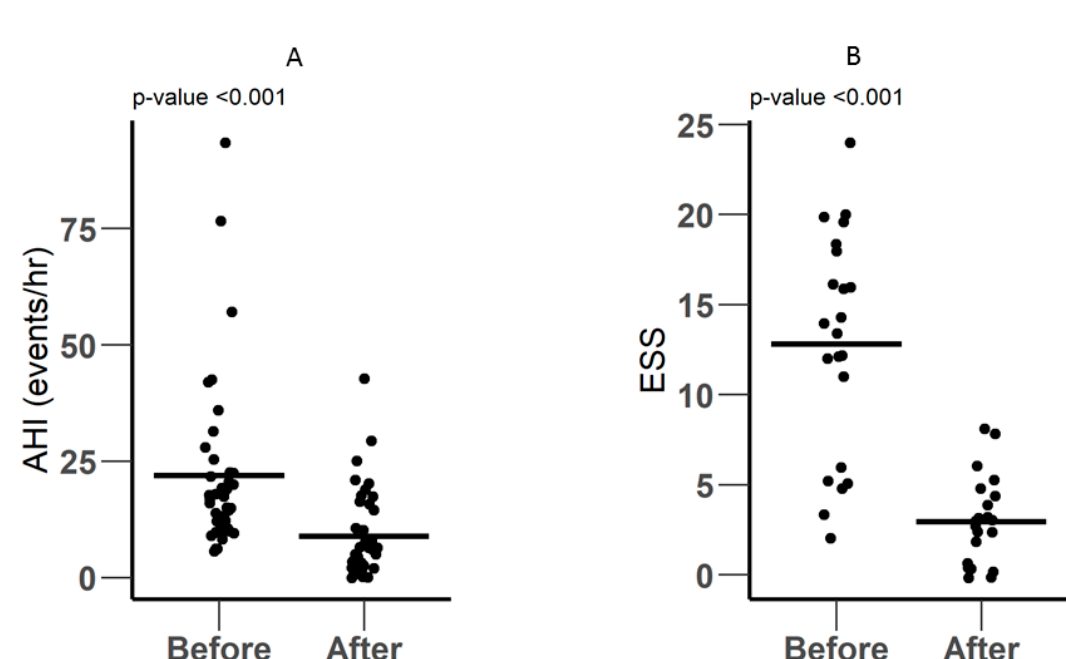
Figure 1. Polysomnographic data showing ( A ) the AHI score and ( B ) the ESS score, before and after the surgery. OSA was diagnosed based on an AHI >5 events/hour.